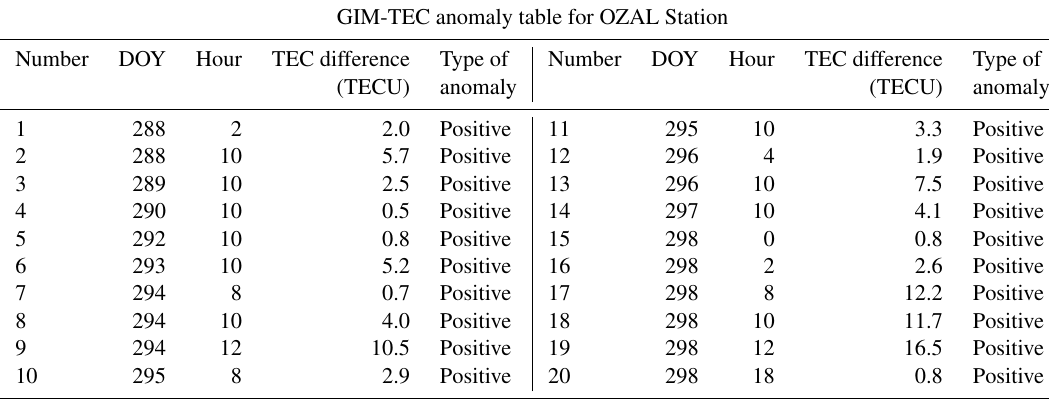
Table 1. OZAL Station global ionosphere model anomaly table.